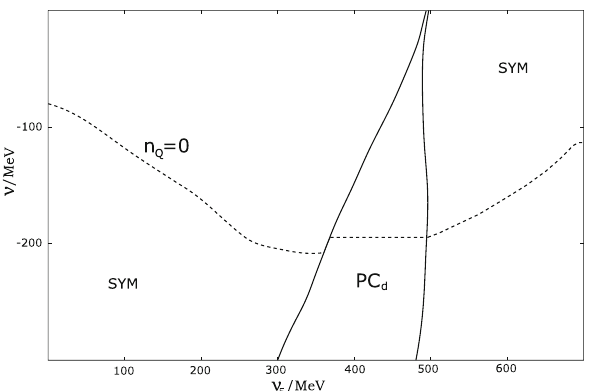
Fig. 8 The (ν 5 ,ν) -phase diagram of β -equilibrium quark matter (see the models (7), (8)) at μ = 500 MeV and μ 5 = 150 MeV in the chiral limit, m 0 = 0. All the notations are the same as in Figs. 1, 2 and